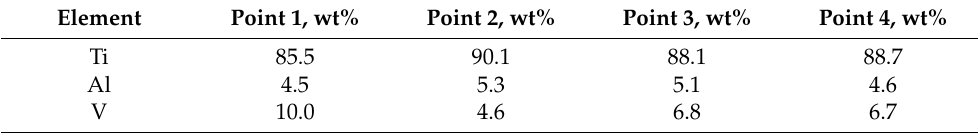
Figure 4. TEM bright ( a ) and dark-field micrographs ( b ) and the associated SAED pattern with indexing schemes ( c ) of EBAM Ti-6Al-4V sample. The dark-field TEM micrograph was obtained with the closely spaced 011 β -Ti reflections ( b ). Table 3. Elemental composition of the EBAM Ti-6Al-4V sample at the points shown in Figure 4a.